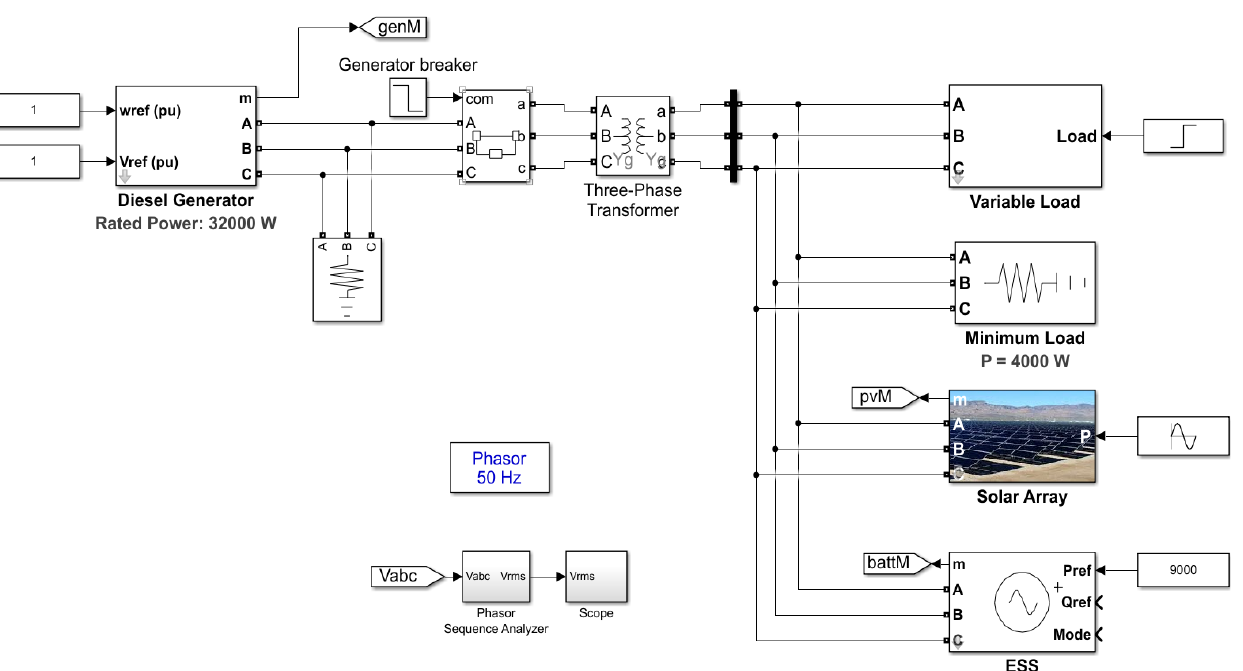
Figure 5. A simulation model created in the Simulink with the blocks' input/output connections.